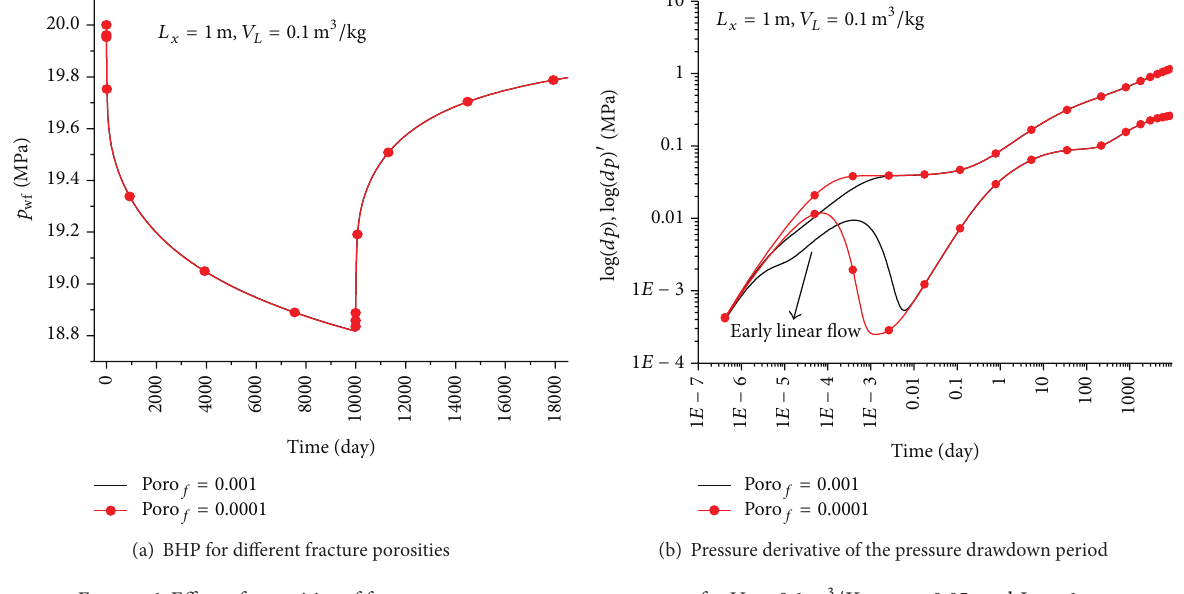
Figure 6: Effect of porosities of fracture system on pressure response for 𝑉 𝐿 = 0.1 m 3 / Kg, 𝜑 𝑚 = 0.05 , and 𝐿 𝑥 = 1 m.